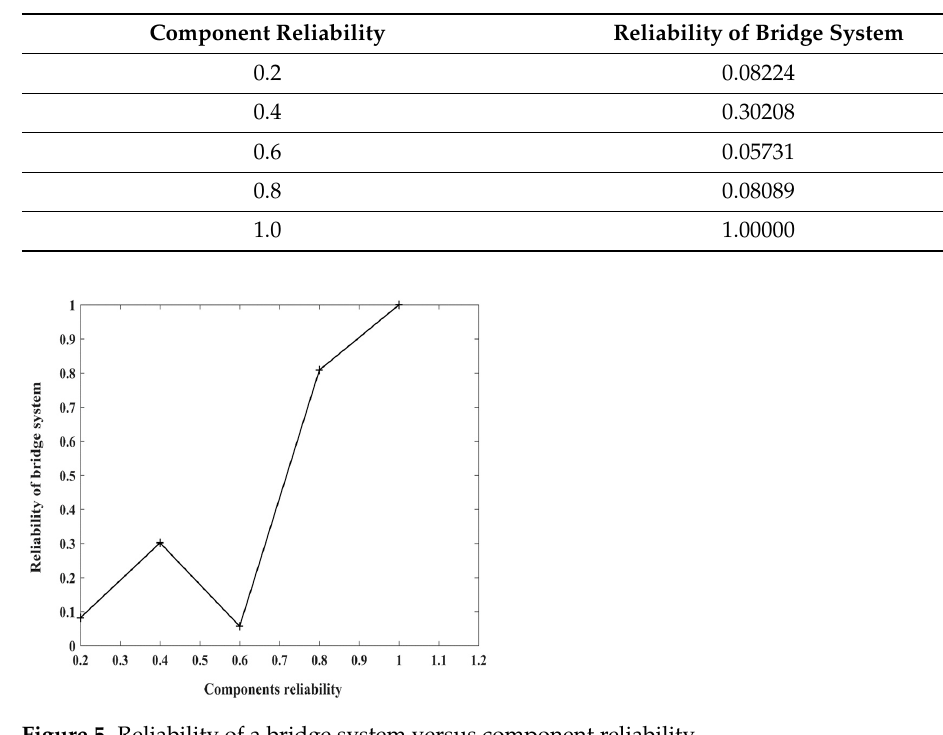
Table 1. The values of reliability of bridge system.